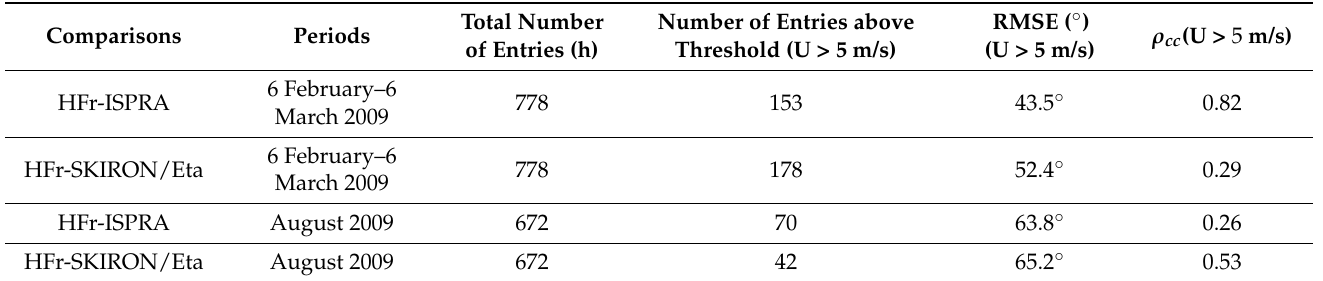
Table 1. Statistical skill metrics (RMSE and ρ cc ) of the comparisons between HFr, ISPRA weather station and SKIRON/Eta model related to wind direction relative to the entire winter and summer datasets with U > 5 m/s.